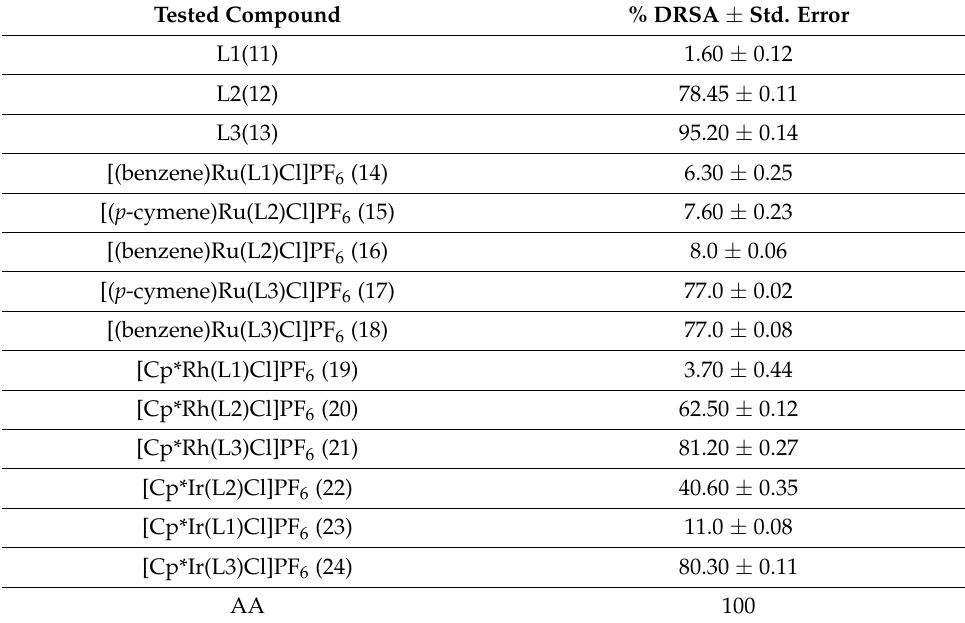
Table 2. DPPH radical scavenging performance of the studied compounds